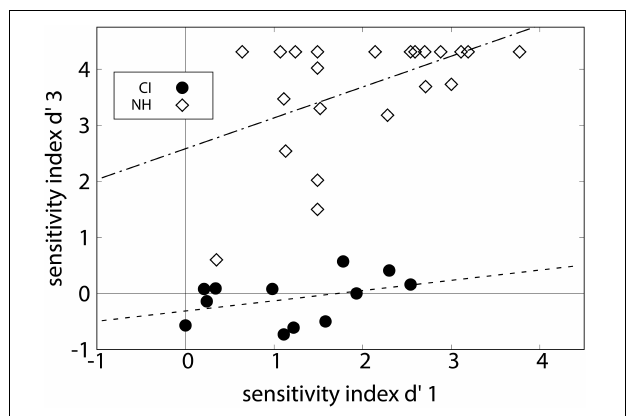
FIGURE 7 | Individual sensitivity indices d (cid:48) of experiment 3 are plotted versus the corresponding values of experiment 1 for CI listeners (circles) and NH listeners (rhombs) with corresponding correlation